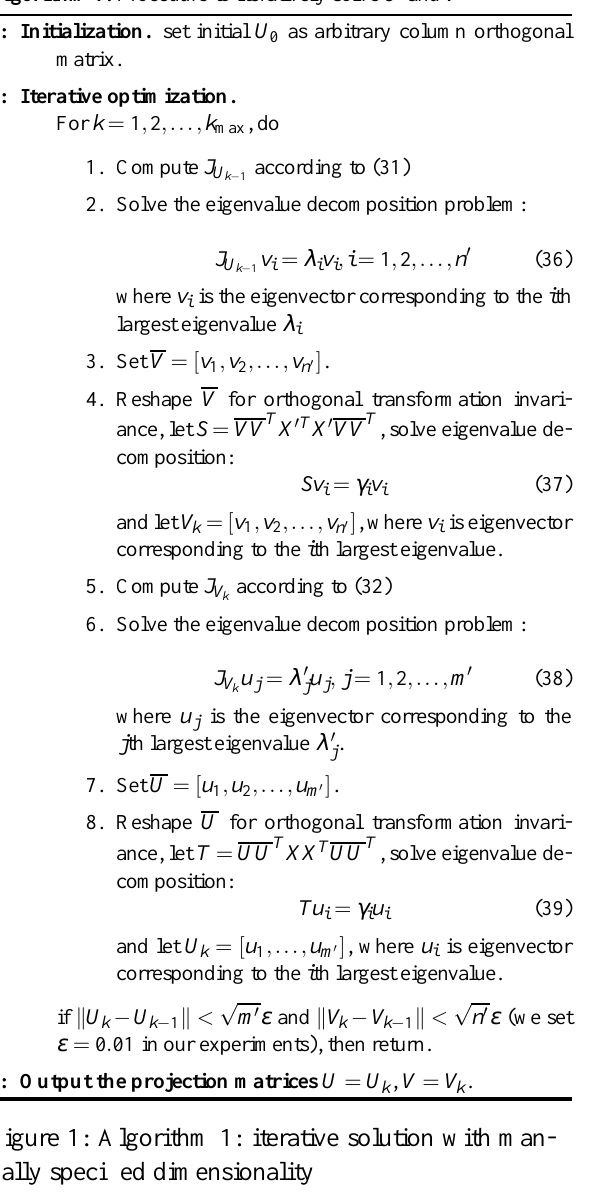
Algorithm 1. Procedure to iteratively solve U and V